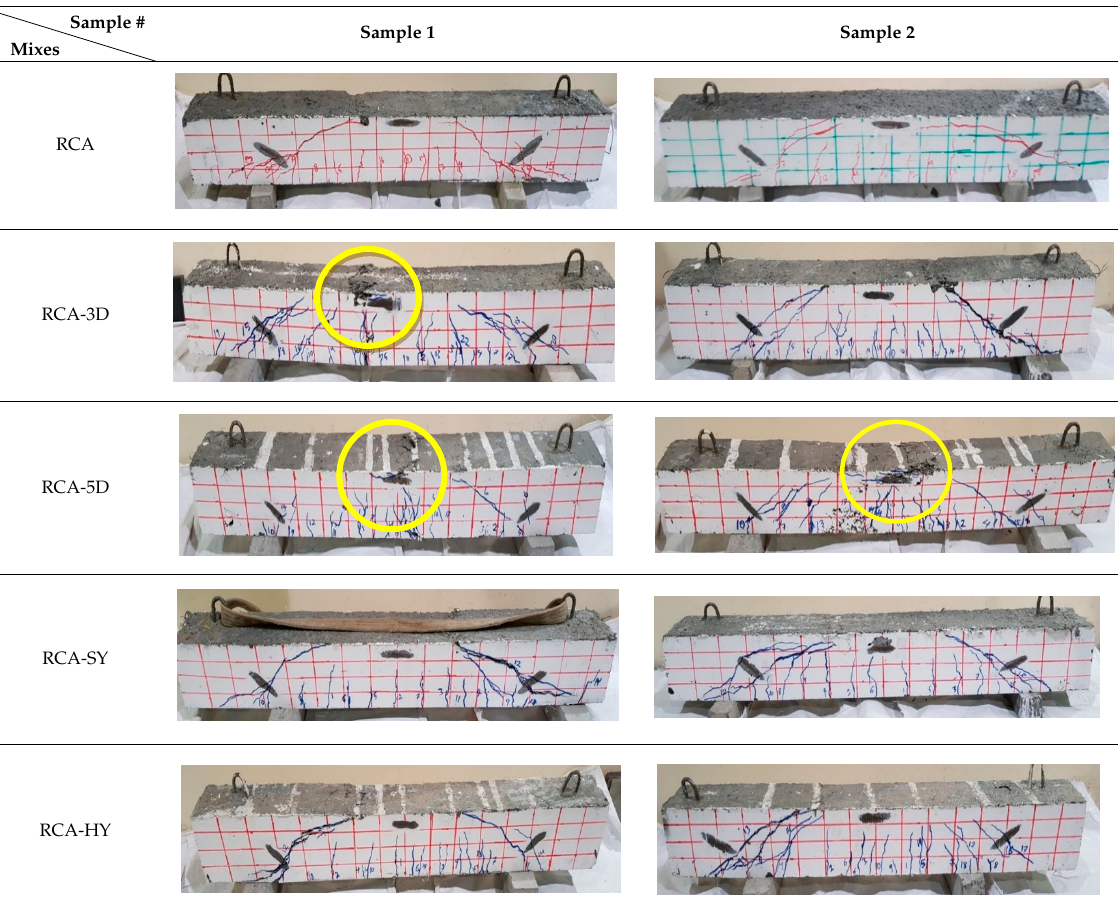
Table 12. Crack distrubtion—beams after testing.